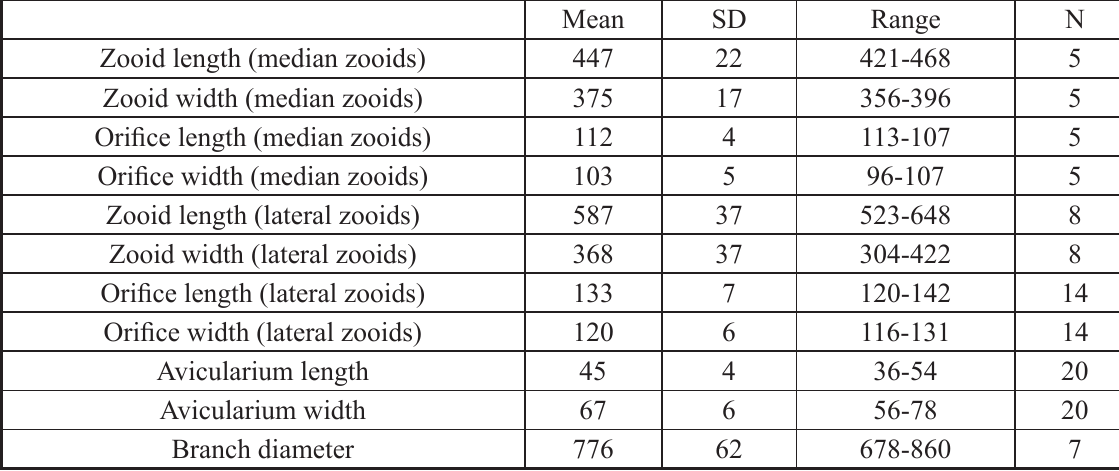
Table 5. Measurements (in µm) of skeletal characters of Characodoma strangulatum (Calvet, 1906), taken from the syntype specimens MnHn 492, 493 and 2471 (see text for morphometric variability between specimens). Due to the convex colony surface, zooecial measurements of the extremely elongated latero-abfrontal zooids could not be taken. SD = standard deviation, n = number of